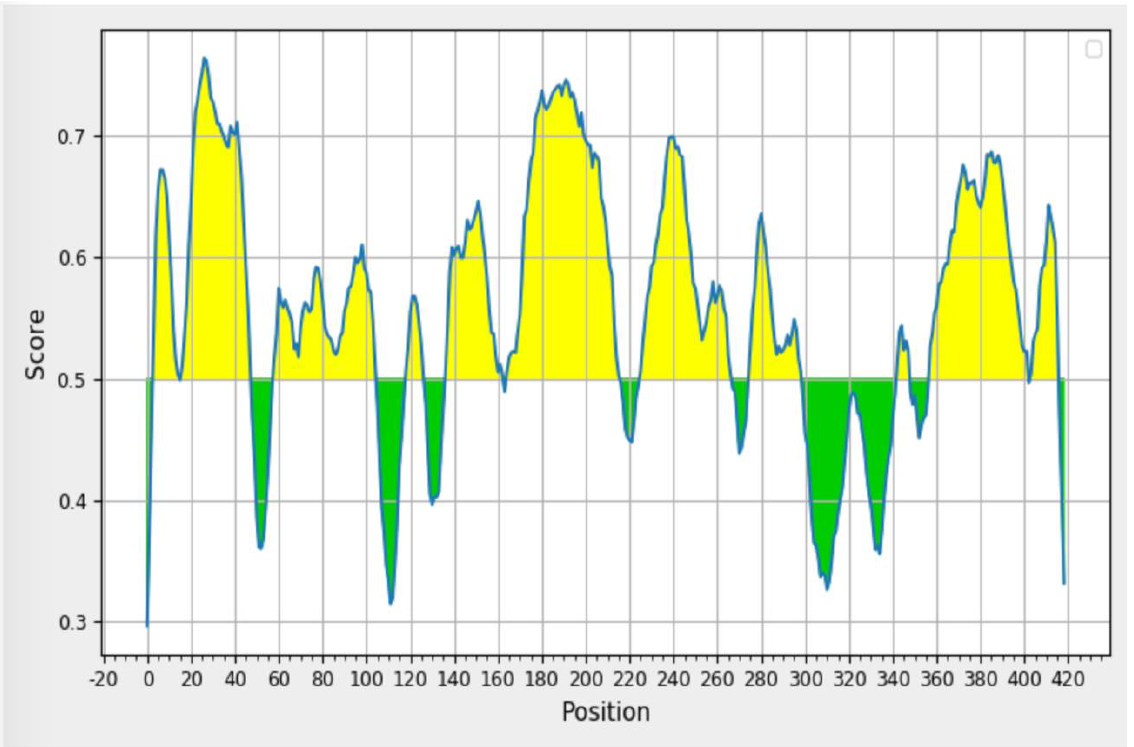
Figure 3. Prediction of B-cell epitopes from the amino acids of N protein of SARS-CoV-2. B-cell epitope prediction was performed using the IEDB online webserver. The region with yellow color indicates a positive prediction, meanwhile, the region with green color indicates a negative prediction of B-cell